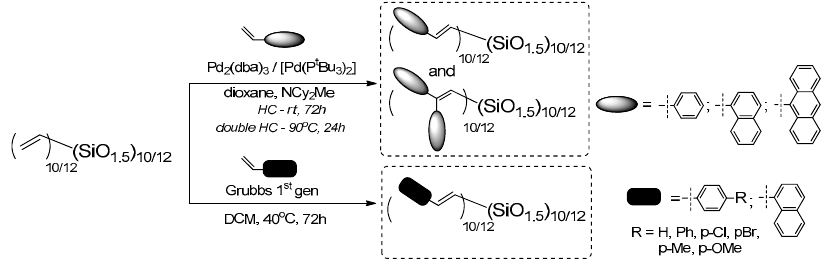
Figure 12. Synthetic approach for linear copolymers obtained via consecutive Heck and Sonogashira coupling.